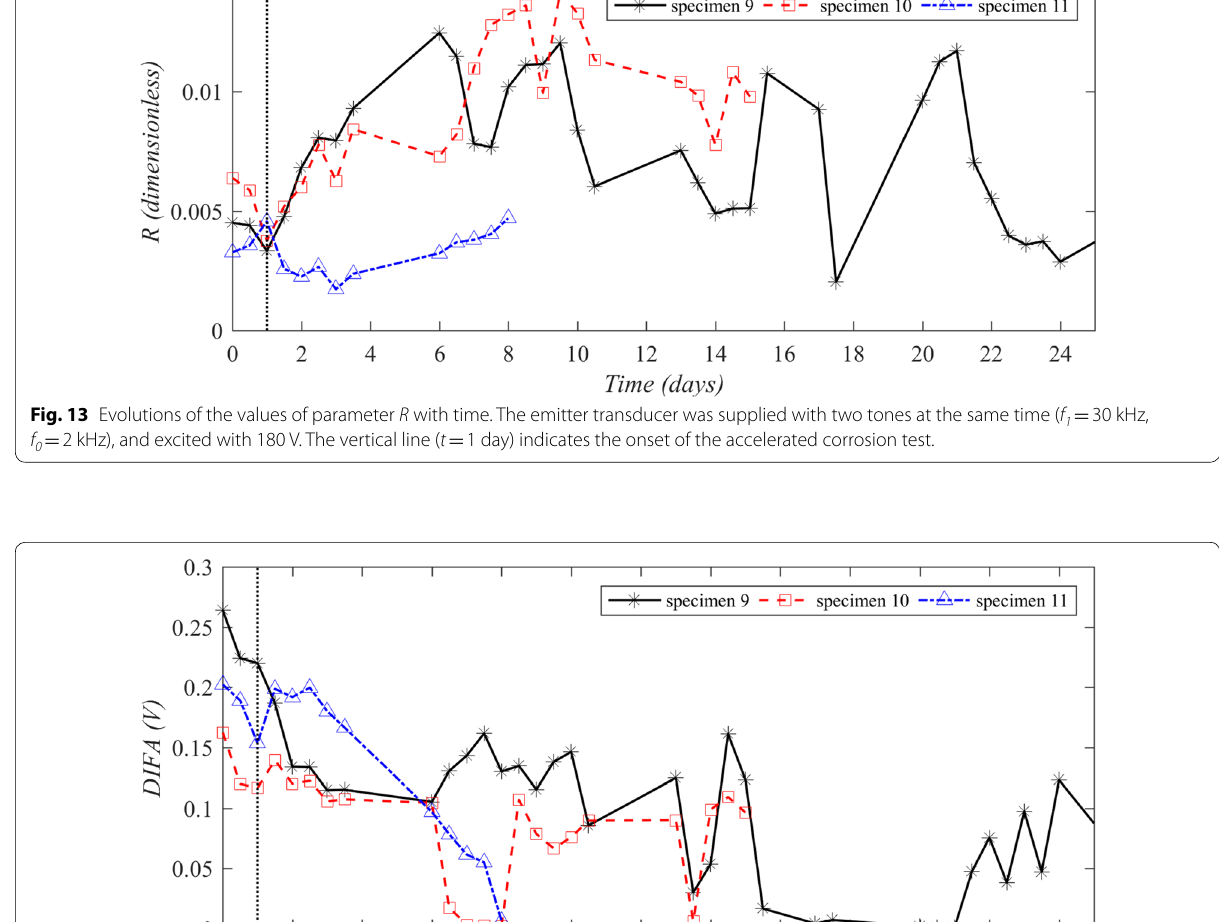
Fig. 14 Evolutions of values of the parameter DIFA with time. The vertical line ( t